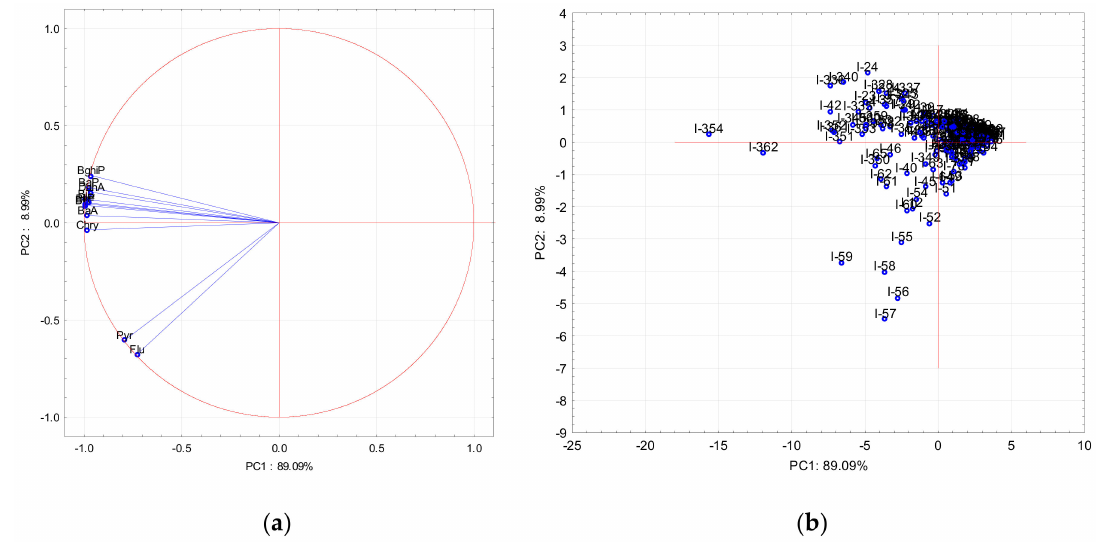
Figure 6. PC1-PC2 loading ( a ) and score plot ( b ) during cold period. I-1 to I-365 are the numbers of days.